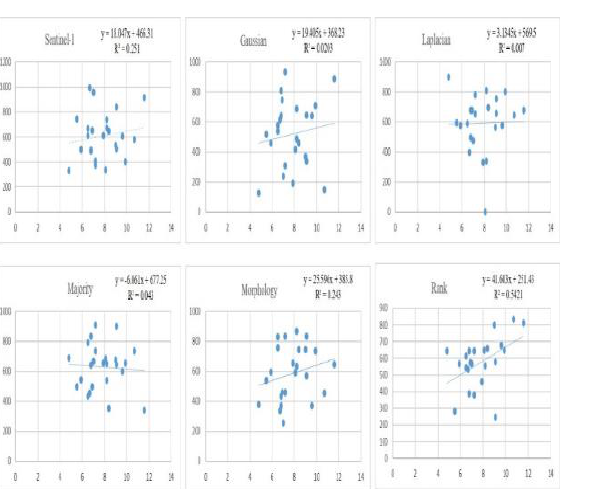
Figure 4. Sentinel-1 sensor product determination coefficient diagram.